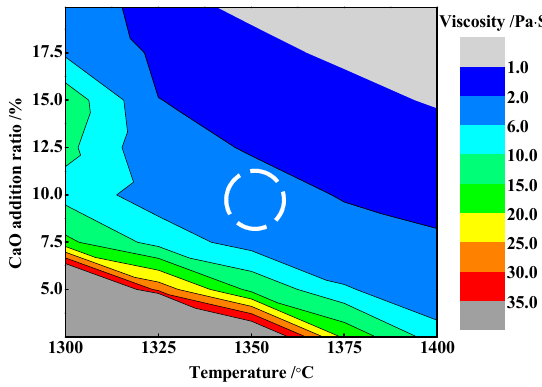
Figure 15. Effect on slag system viscosity by CaO addition.